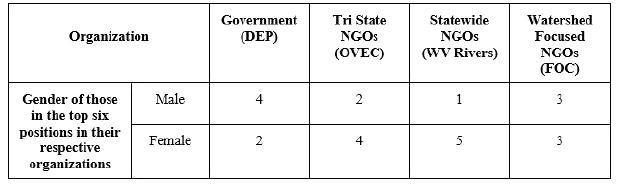
Fig. 2 . Typology of organizations and composition of organizations; data gathered from the top six staff positions for each organization. (DEP, Department of Environmental Protection, Division of Water & Waste; OVEC, Ohio Valley Environmental Coalition; WV Rivers, West Virginia Rivers; FOC, Friends of the